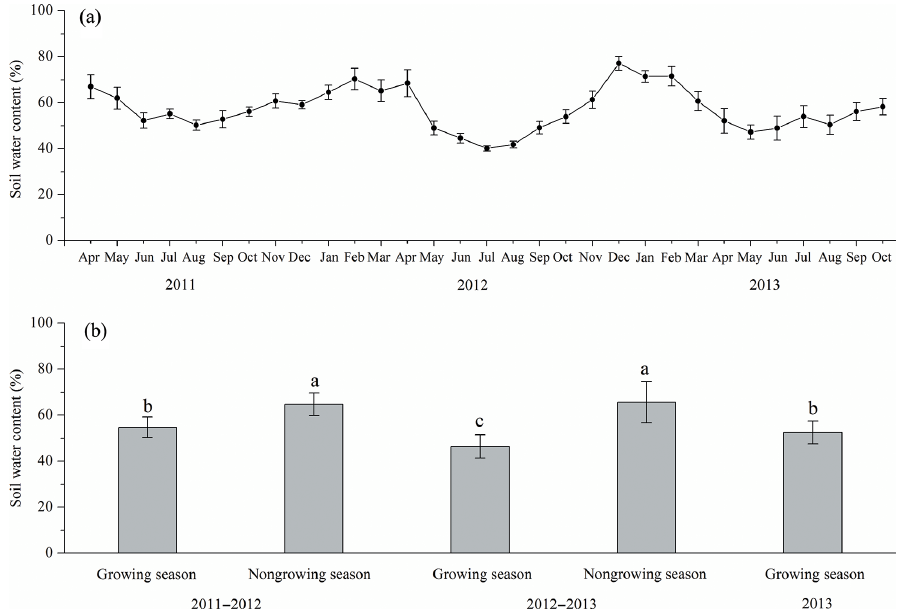
Figure 3. Dynamics of soil water content ( a ; mean ± SE; n = 15) and its seasonal and interannual differences ( b ; mean ± SE; n = 90) from 2011 to